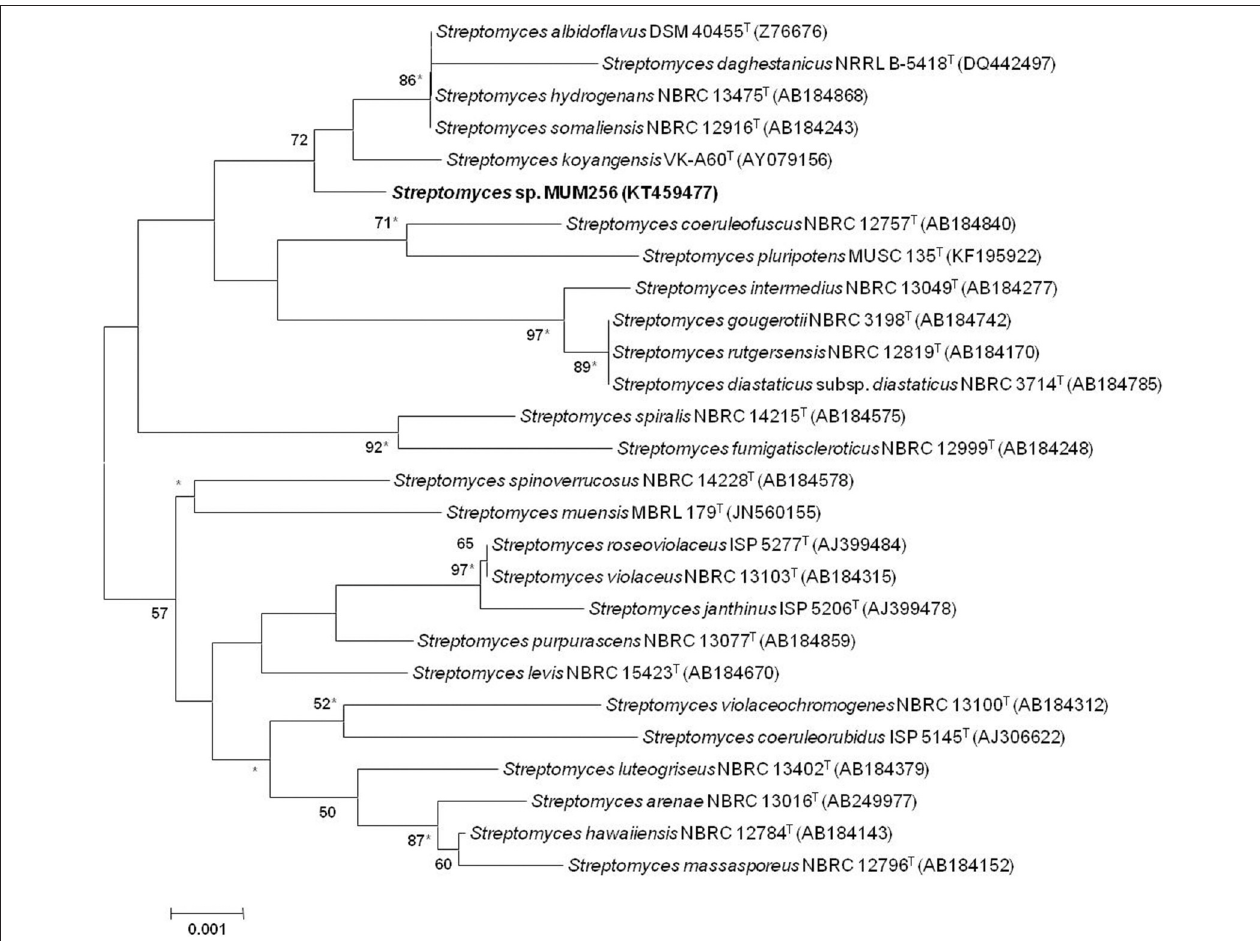
FIGURE 1 | Neighbor-joining phylogenetic tree based on 1487 nucleotides of 16S rRNA gene sequence showing the relationship between strain MUSC 149 T and representatives of related taxa. Numbers at nodes indicate percentages of 1000 bootstrap re-samplings, only values above 50% are shown. Bar, 0.001 substitutions per site. Asterisks indicate that the corresponding nodes were also recovered using the maximum-likelihood tree-making